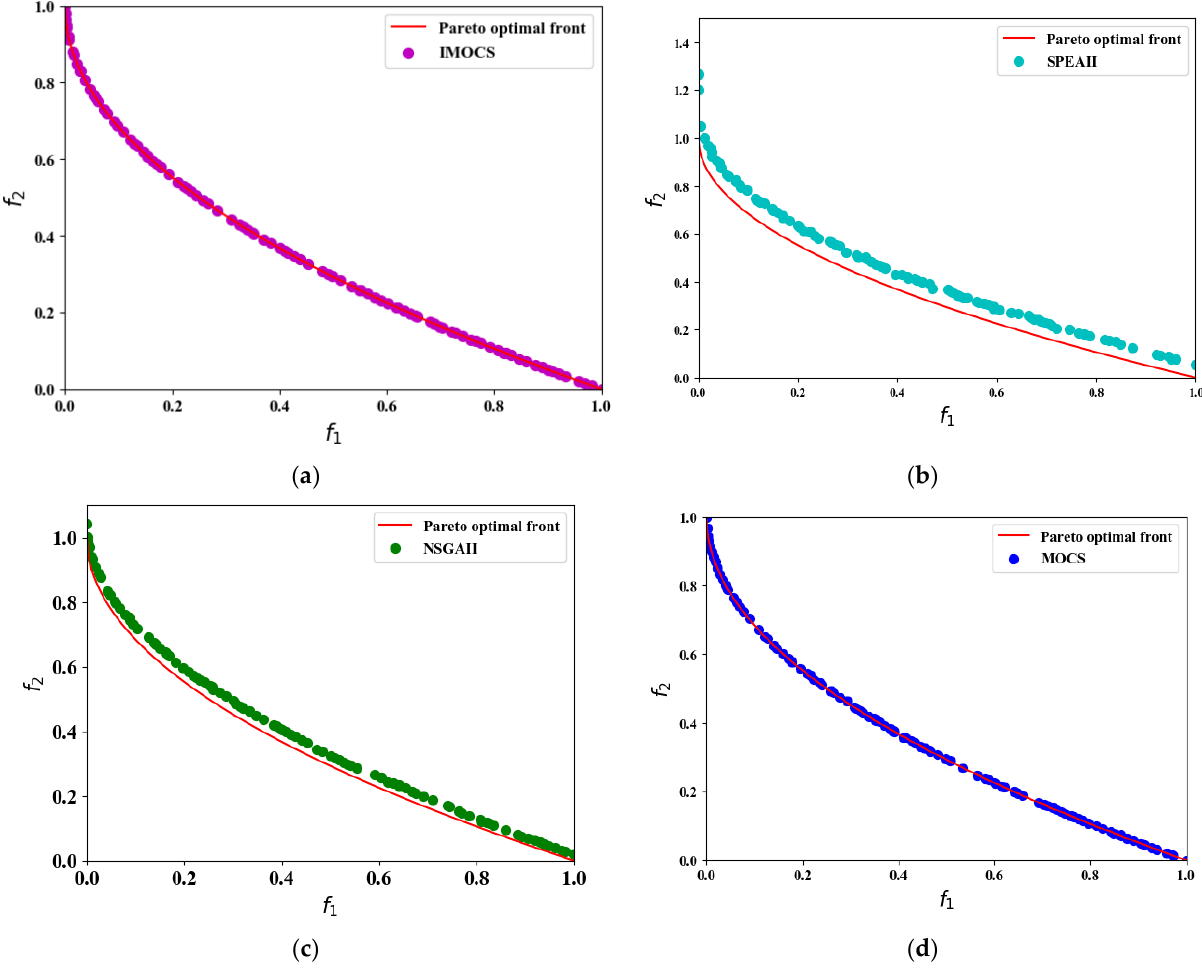
Figure 2. The convergence results of ZDT1 test problem over all algorithms. ( a ) IMOCS, ( b ) SPEAII,